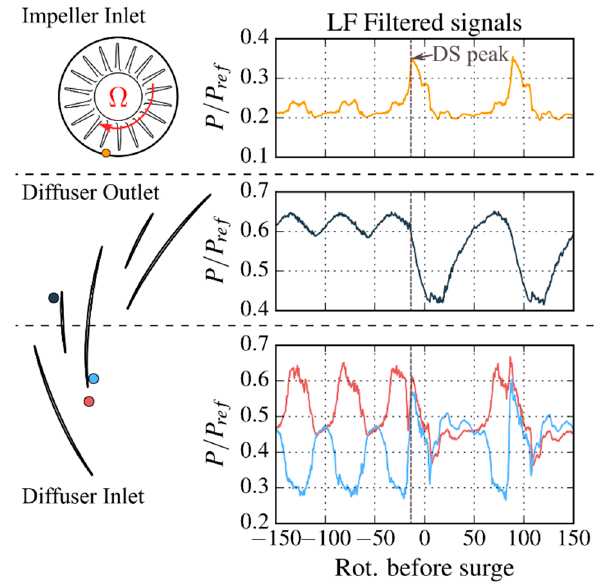
Figure 12. Comparison of pressure signals during periods of mild and deep surge .